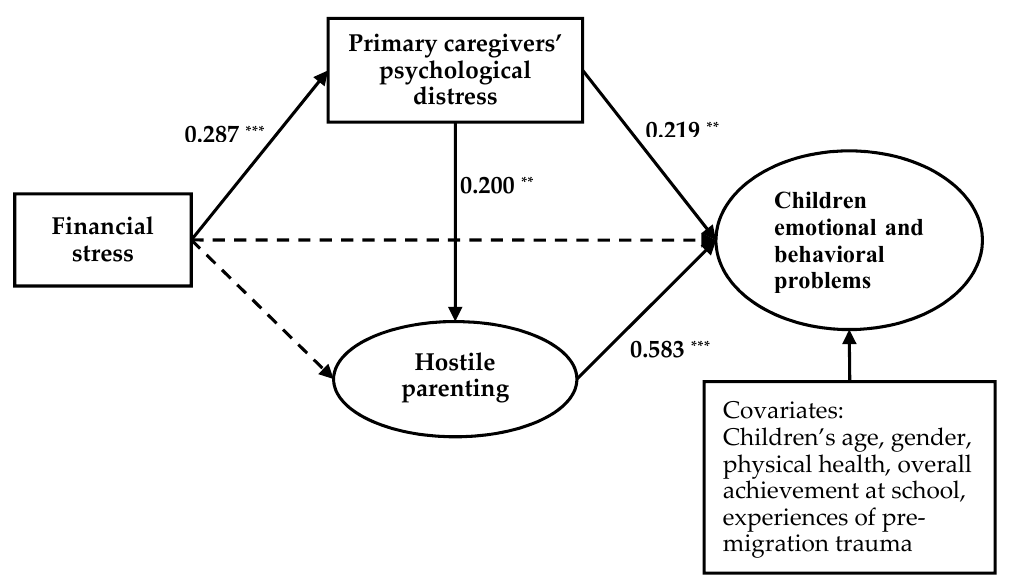
Figure A1. Basic FSM. Note . ** p < 0.01, *** p < 0.001. Coefficients are standardized path coefficients. The solid lines represent significant paths ( p < 0.05). The dashed lines represent non-significant paths. Children’s age, gender, physical health, overall achievement at school, and experiences of pre-migration trauma are included as covariates. Model fitting indices: 2 (105) = 252.861, p < 0.001, CFI = 0.875, TLI = 0.839, RMSEA = 0.046, SRMR = 0.079. Table A1. Di ff erences in total and subscale SDQ scores reported by primary caregivers and refugee children (Mean